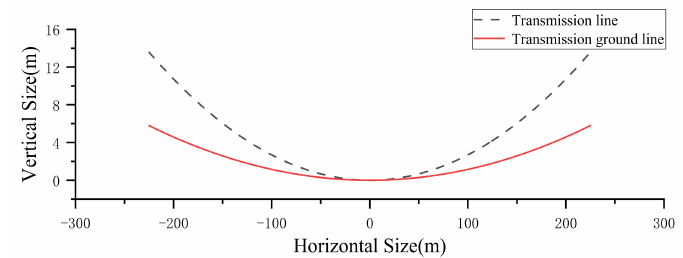
Figure 12. Form finding of conductor and ground line.